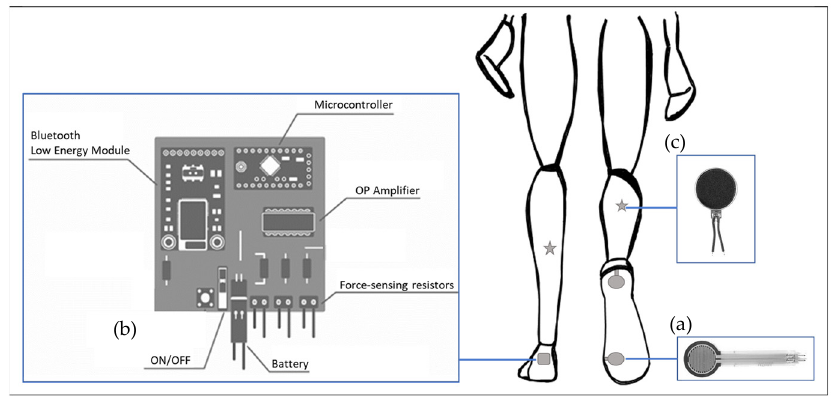
Figure 1. Diagram of the insole system. ( a ) Thin-film FSR placed on an insole diameter 12.7 mm, ( b ) diagram of board and electronics being host in a 3D printed box was attached at the back of each shoe, ( c ) vibrating actuator diameter 10 mm and thickness 3.4 mm place in each leg which was connected wirily to the microcontroller.